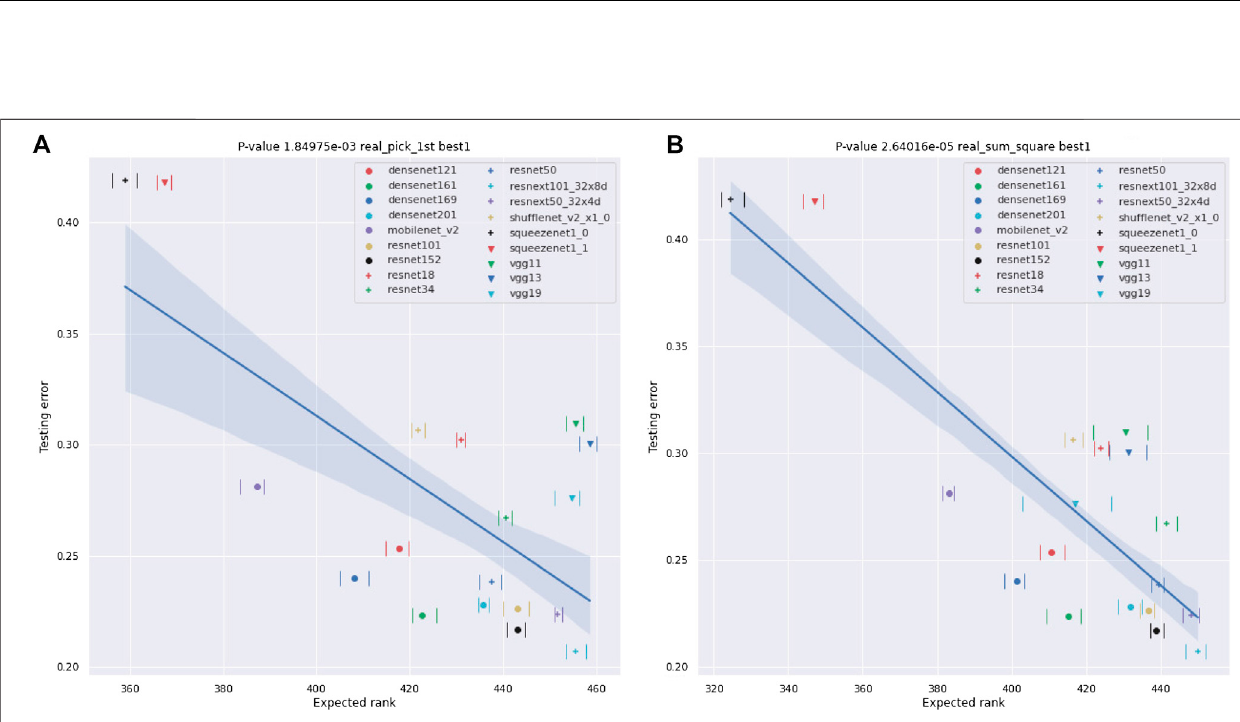
Frontiers in Applied Mathematics and Statistics |